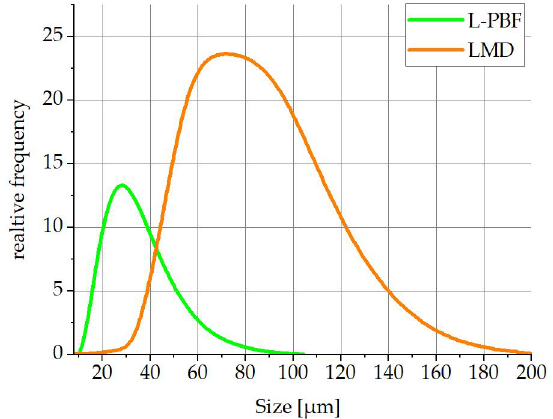
Figure 3. Particle size distributions of the used L-PBF and LMD powder.